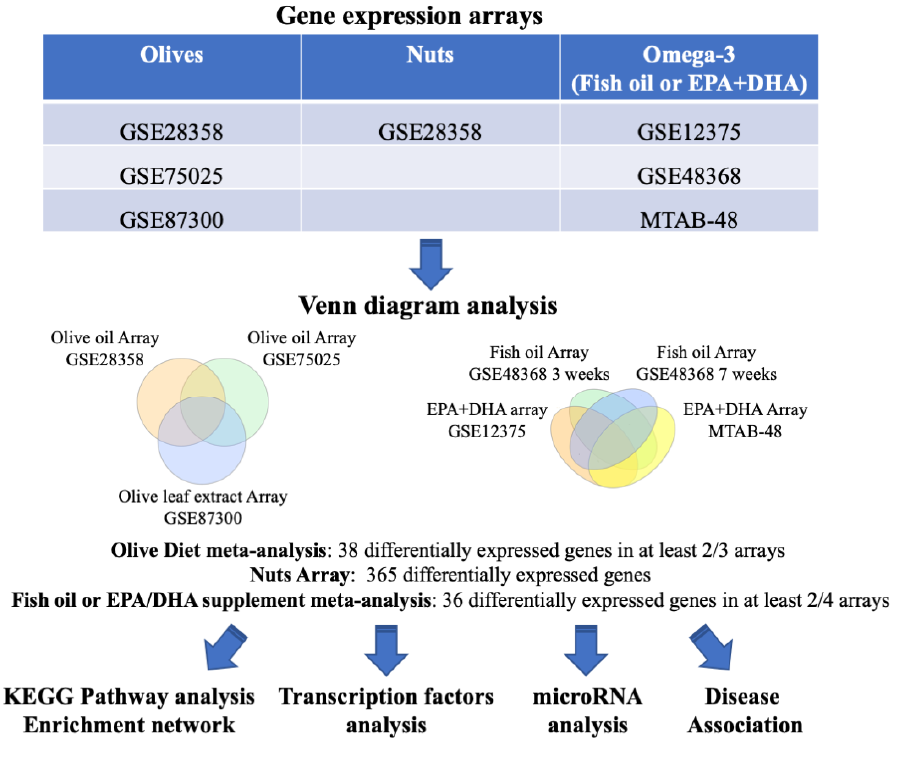
Figure 1. Flowchart of the study. The BaseSpace Correlation Engine (BSCE) was searched to identify microarray data from appropriate diet studies. Venn diagram analysis was used to identify shared differentially regulated genes. The genes shared by olive-, nuts- or omega-3-supplemented diets were analyzed for shared functional pathways, transcription factors, miRNAs regulation, and disease associations.